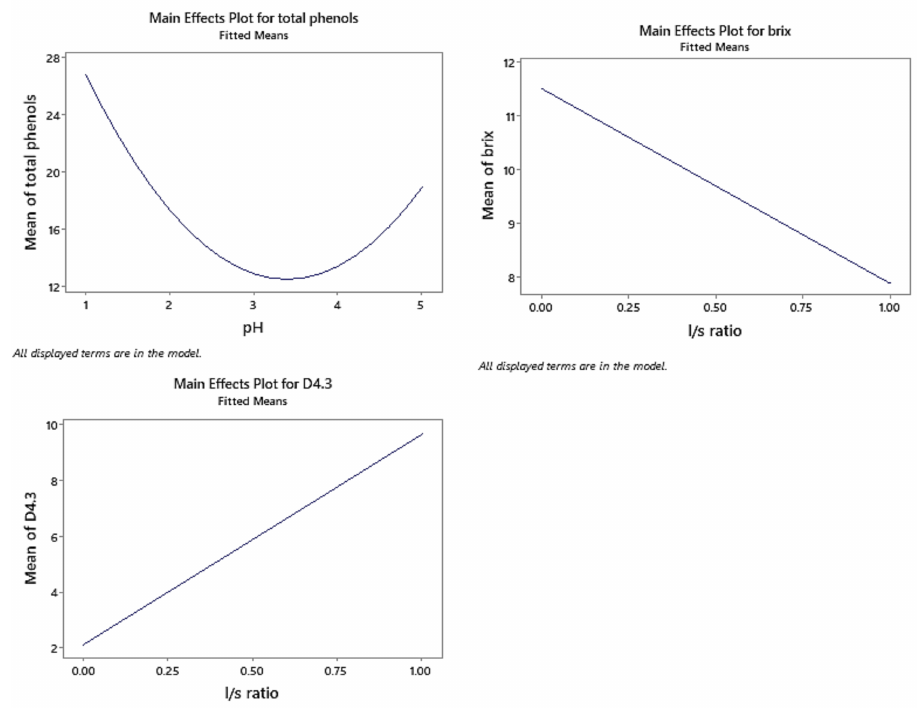
Figure 1. Main effects plot for total phenols, brix, and D4,3.